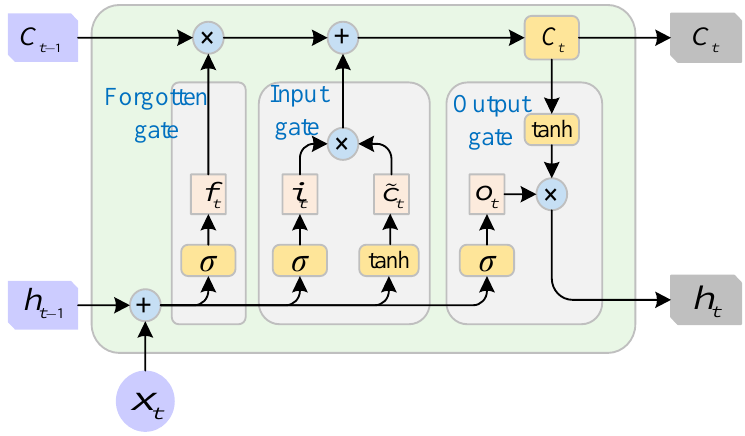
Figure 3. Basic structure of LSTM.